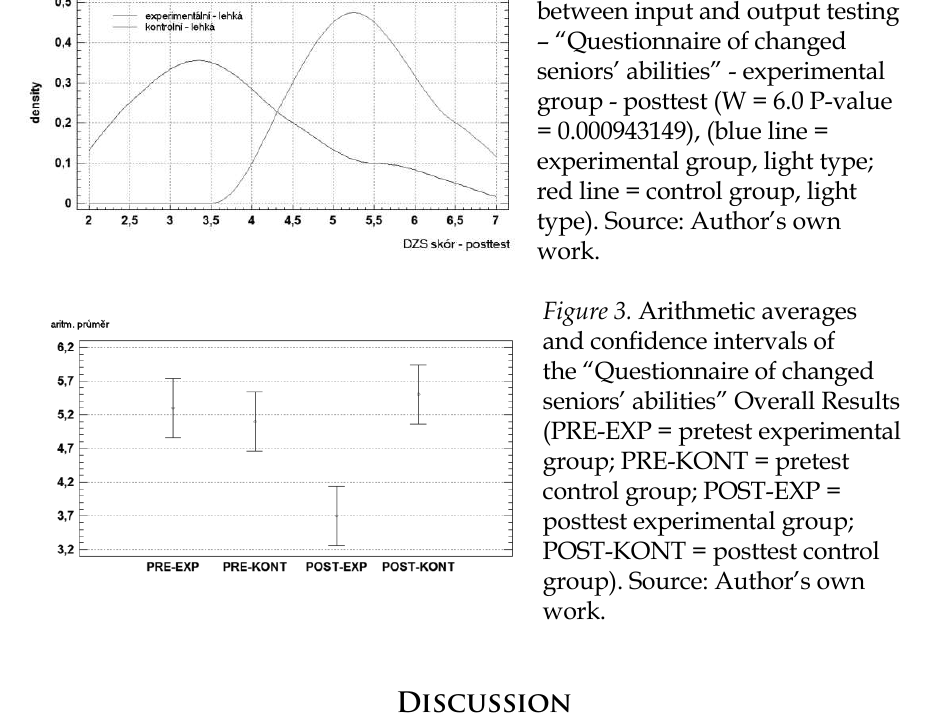
Figure 2. Distribution of difference